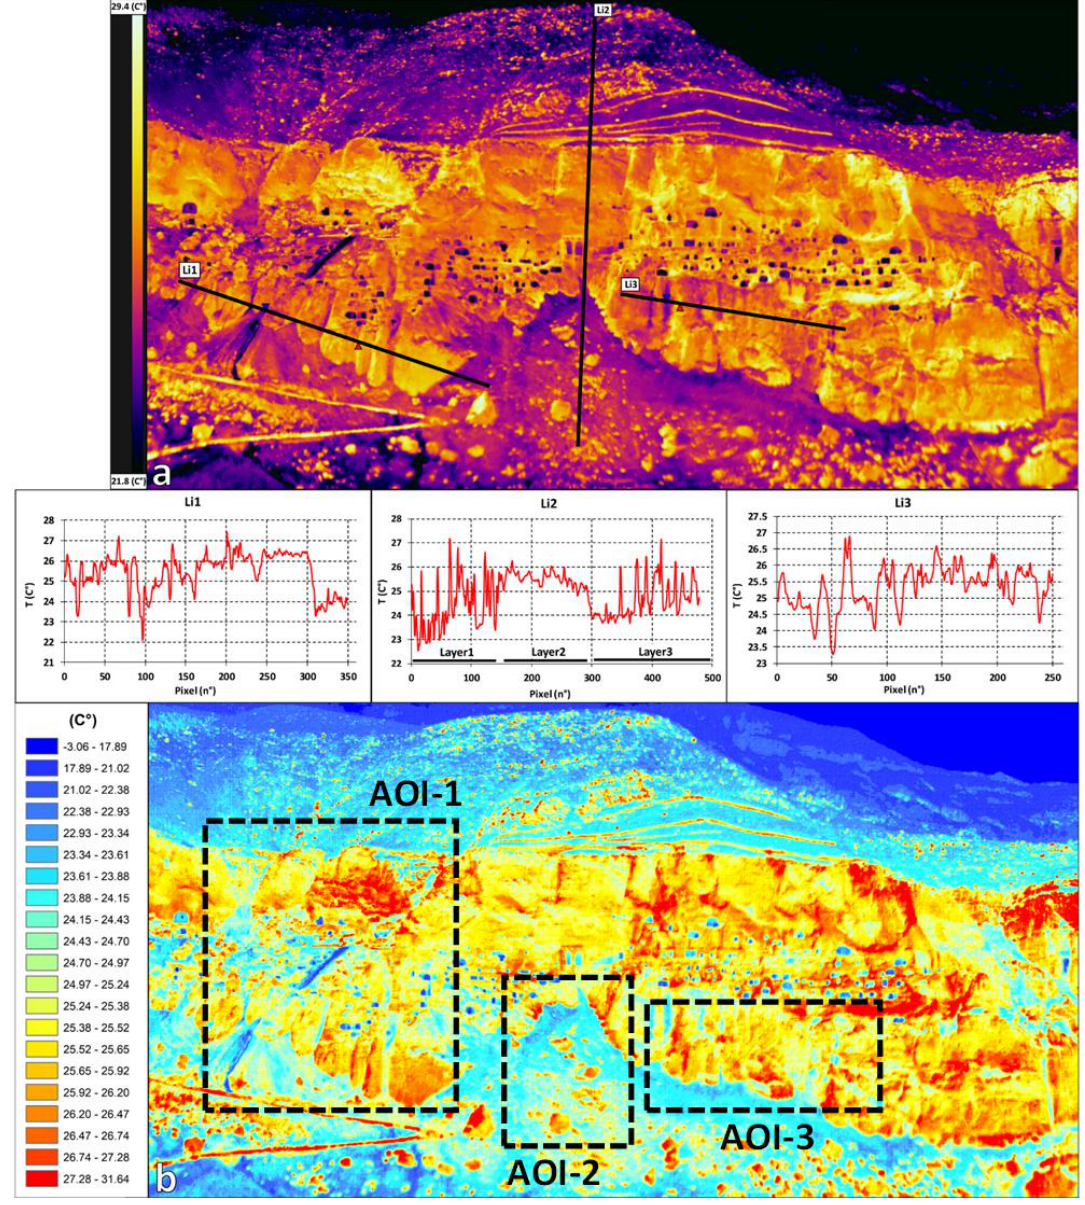
Figure 8. IRT data acquired in S1: a ) Mosaicked thermograms acquired on July 16 th , 2016 at 19:00, including surface temperature profiles Li1-3, b ) corresponding classified image.